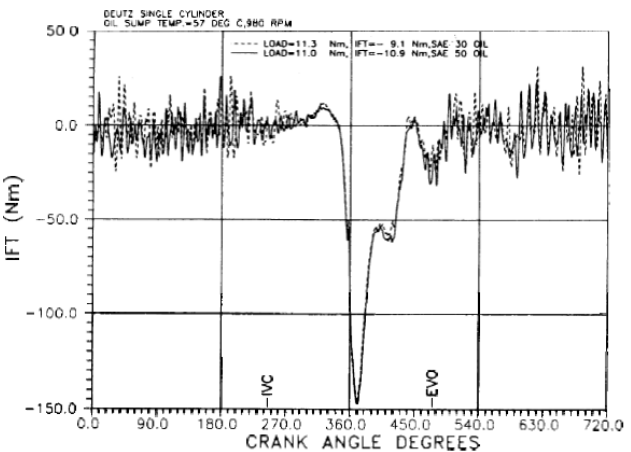
Figure 1. Instantaneous frictional torque of a single cylinder Diesel [2]. This particular case examined the effect of lubricant viscosity in instantaneous friction. The unclear legends in the figure refer to the oil temperature (57 ◦ C) and the